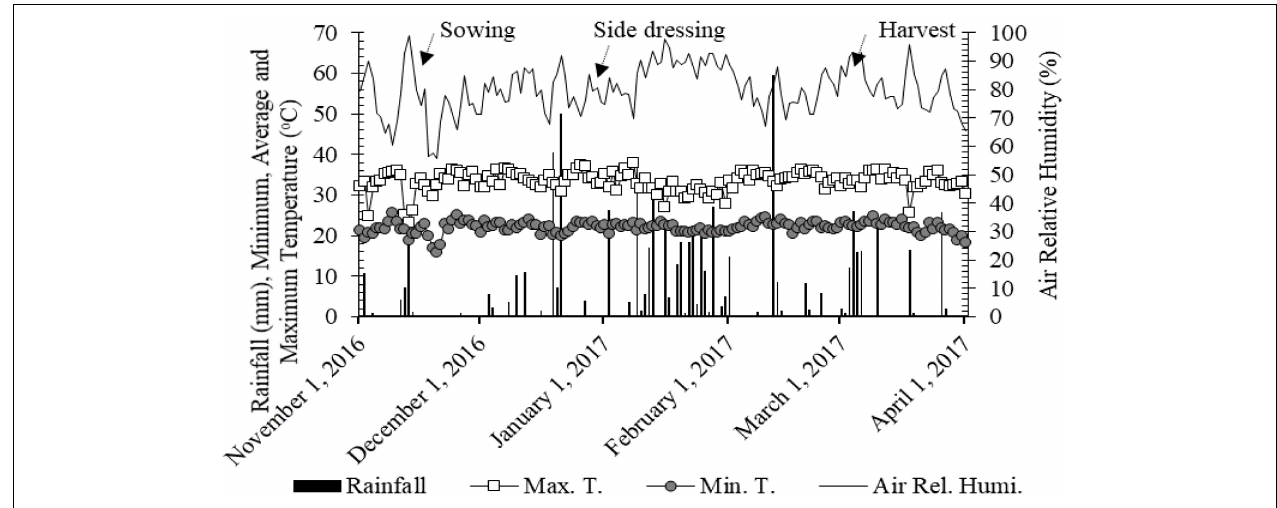
FIGURE 1 | Rainfall, air relative humidity, maximum and minimum temperatures obtained from the weather station located in the Education and Research Farm of FE/UNESP during the corn cultivation in the period November 2016 to April 2017.